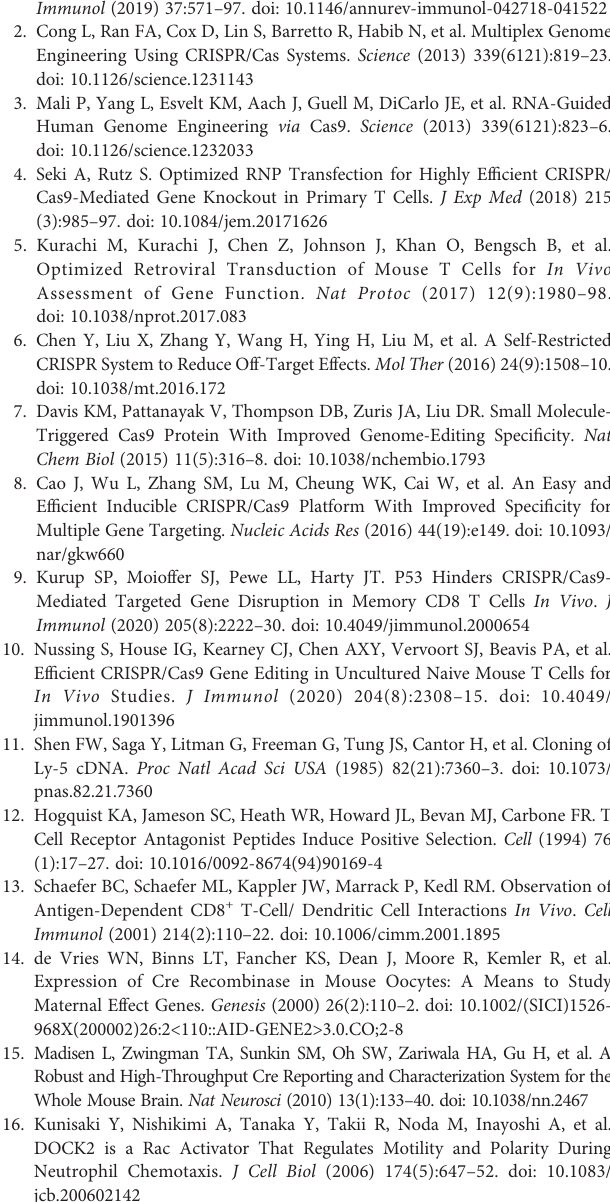
Supplementary Figure 8 | Scatter plots of the data shown as pie charts in . Frequency offour subsets de fi ned by the expression of CD127 and KLRG1 on day 7. * p < 0.05, ** p < 0.01 as compared to NTC by ordinary two-way ANOVA with Dunnett ’ s multiple